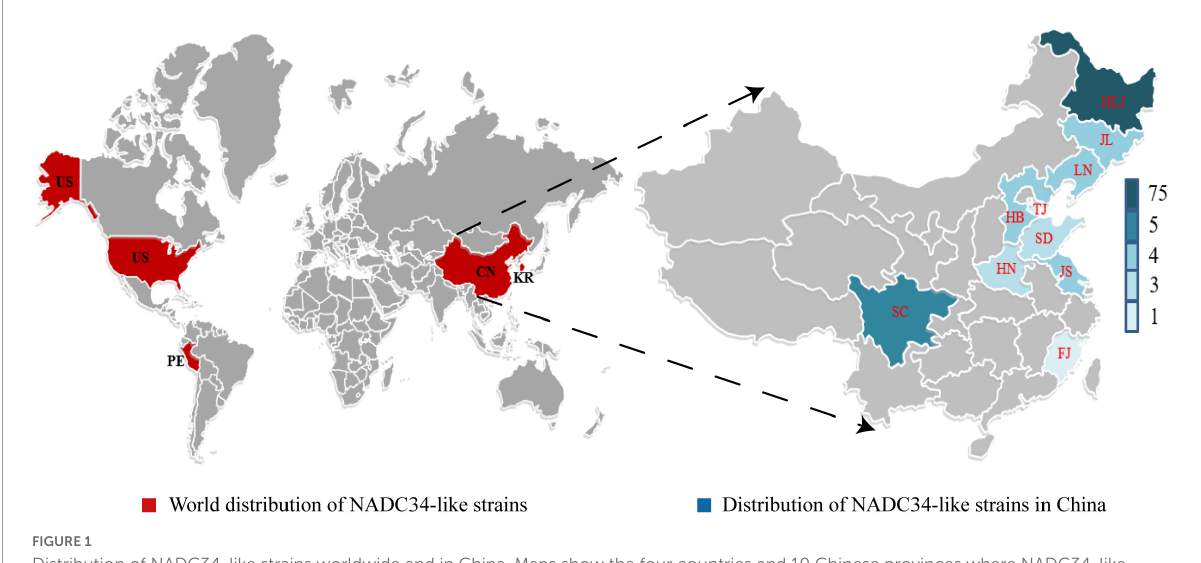
FIGURE1 Distribution of NADC34-like strains worldwide and in China. Maps show the four countries and 10 Chinese provinces where NADC34-like strains have been identified to date: China, the United States, Peru, and South Korea. On the world map, countries known to harbor NADC34-like strains are colored red. On the map of China, provinces known to harbor NADC34-like strains are colored blue, with color intensity increasing with the number of unique NADC34-like strains identified. HLJ, Heilongjiang Province; JL, Jilin Province; LN, Liaoning